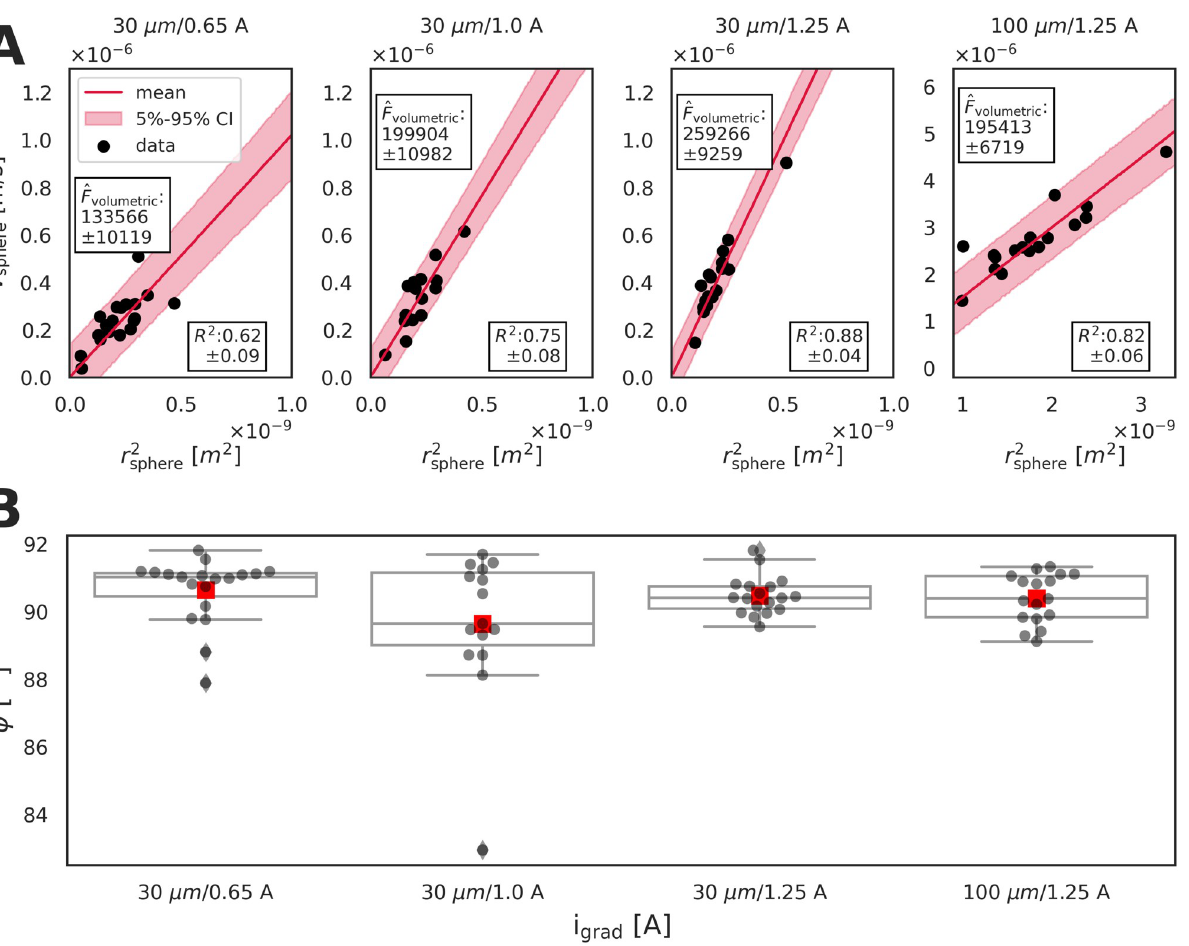
Fig 3. Microrheometer calibration based on volumetric force ( ^ F ) and phase angle ( ϕ ) as a function of varied currents ( i grad ). A : Relation volumetric ) and the average sphere velocity ( ^ v ) is shown as black spheres. The R 2 values show the goodness of fit of between the squared sphere radius ( r 2 sphere sphere the linear curves [49]. The red shadowed areas indicate the credible intervals of the estimates. Increasing the value of i grad enlarges the measured volumetric forces (i.e. steeper slope) exerted onto the magnetic spheres, as previously reported [45]. As the calibration for both the 30 and 100 μ m spheres, the ^ F constant values at i grad = 1.25 A were calculated based on the linear fits (red line), and used in all further experiments. B : Relation volumetric between the phase angle ( ϕ ) and the current i grad is presented. The measurements are scattered around the ideal value of 90˚ for purely viscous materials. The dark grey spheres show the ϕ values measured by individual magnetic spheres, while the red squares are the mean values of the spheres. Standardly, the plots’ box and whiskers indicate the lower/upper extremes, the 25% and the 75% percentiles, and the median. Each dataset indicates whether the calibration is for the 30 μ m or the 100 μ m